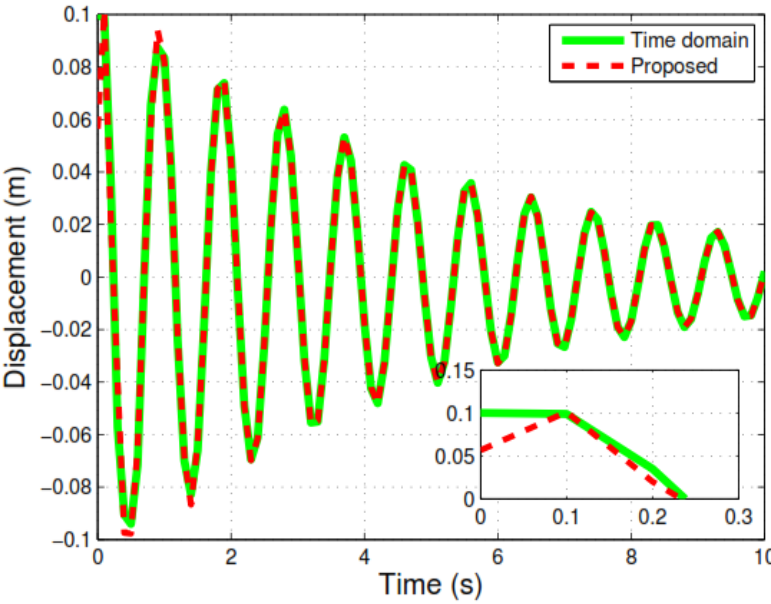
Figure 4. The response comparison at the top of the tower in the y direction when only nonzero displacements are applied.